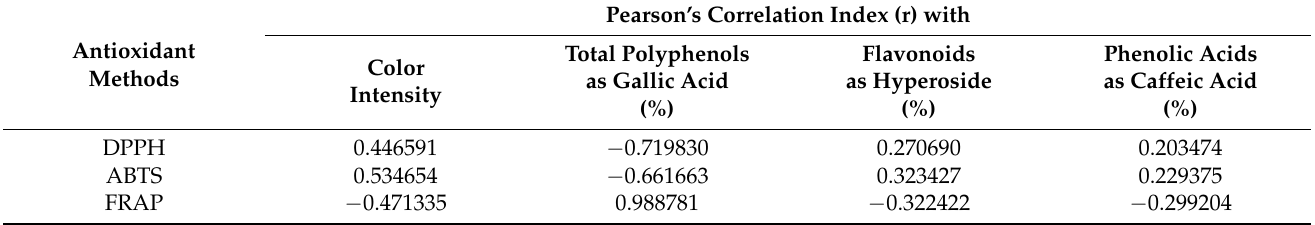
Table 5. Correlation between color intensity, total polyphenols, flavonoids, and phenolic acids content and antioxidant